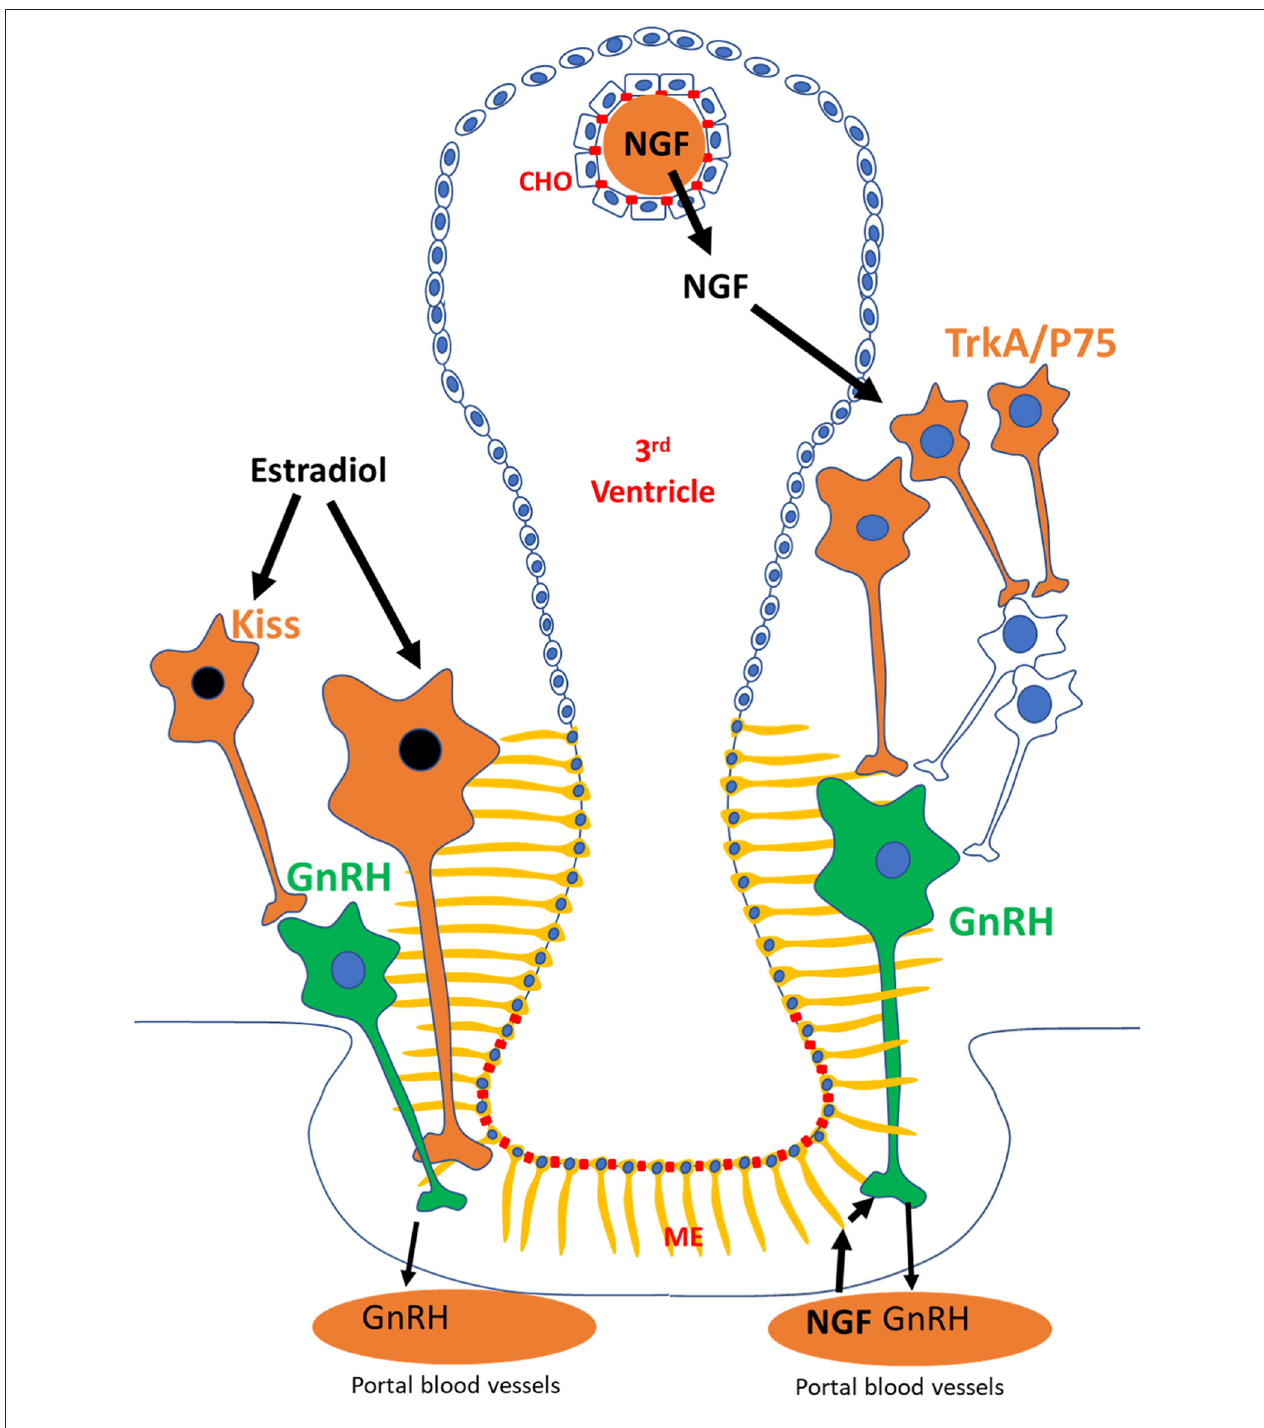
FIGURE 1 | Proposed mechanistic pathways followed by estradiol and NGF in the hypothalamus of llamas to trigger ovulation. Estradiol, through neuronal populations (i.e., kisspeptin; kiss) expressing its nuclear receptor (black), may be influencing GnRH neurons (green) to trigger an LH surge. In contrast, the effects of NGF on GnRH neurons may be triggered by activation of NGF receptors (TrkA and P75) in hypothalamic neurons that act as afferents to GnRH neurons. Alternatively, blood borne NGF may be activating P75 receptor in tanycytes (yellow), which are in close association to GnRH nerve terminals at the portal vessels in the median eminence (ME). CHO, choroid